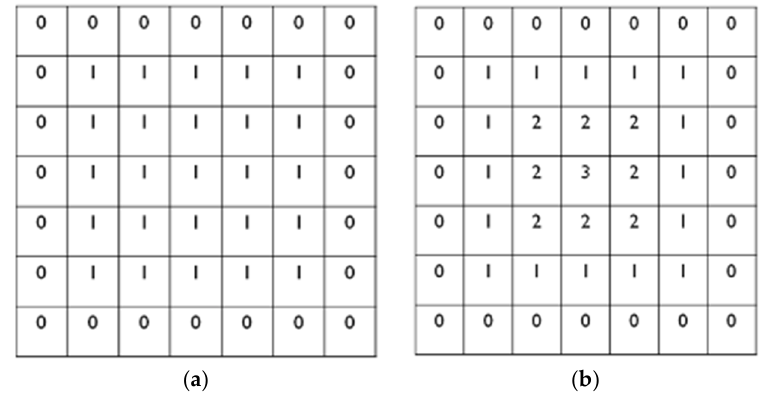
Figure 3. Distance transform process using Euclidean distance: ( a ) binary Image and ( b ) distance transform.